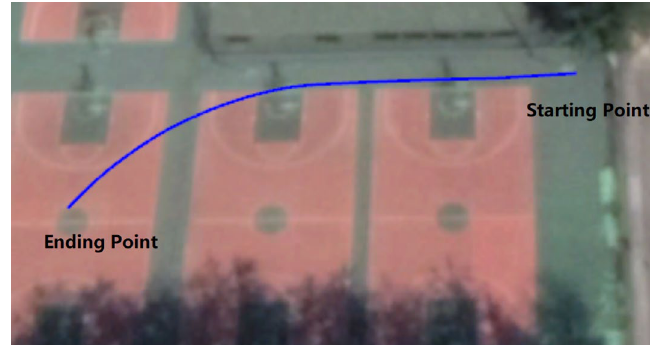
Figure 8. Trajectory description using latitude and longitude variation values.